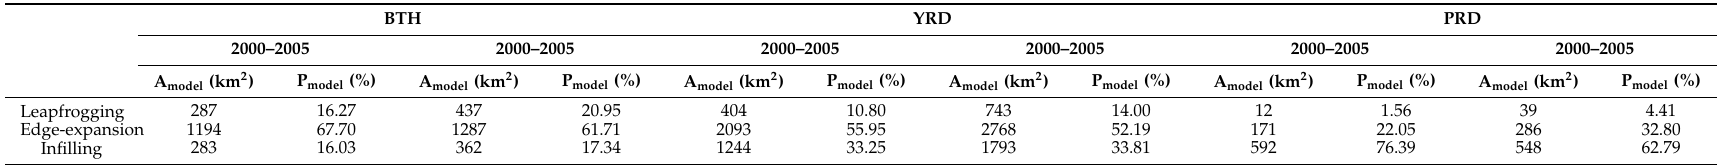
Table 4. The area and proportion of three expansion models in the BTH, YRD and PRD urban megaregions during 2000–2005 and 2005–2010.